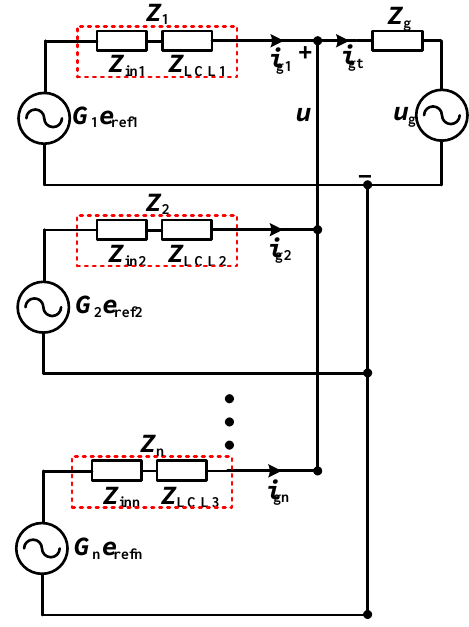
Figure 6. Impedance model of a VSG cluster.